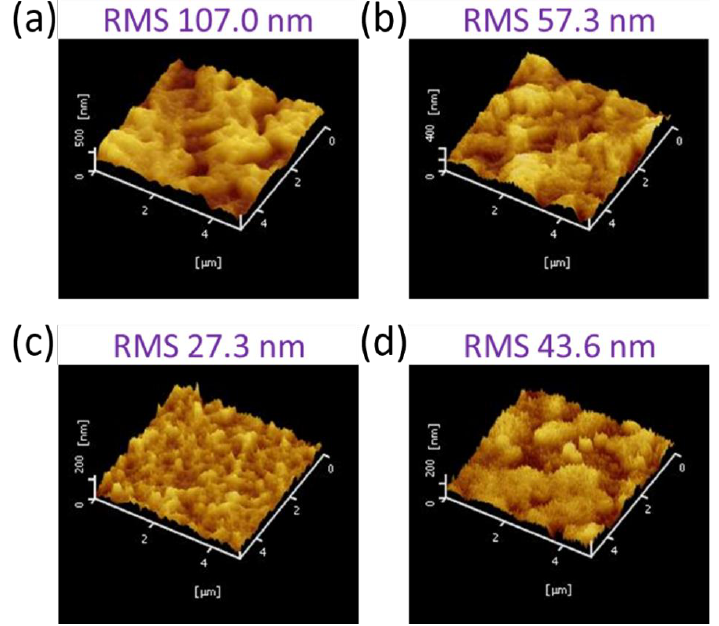
Figure 3. AFM images and RMS of lead halide films deposited at x = ( a ) 0; ( b ) 0.1; ( c ) 0.3; and ( d )